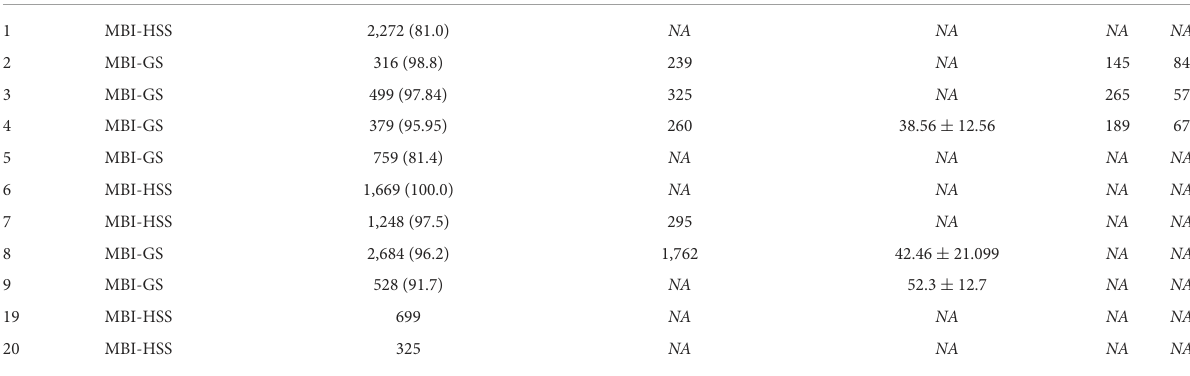
TABLE 3 A characteristic of 11 included studies of job burnout among Chinese